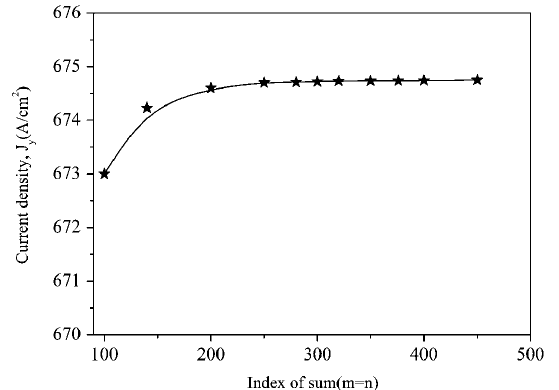
FIG. 6. Evaluation of the eddy current from the analytical expression of Eq. (19) for different indices of the sum ( m ¼ n ). The solid line is just a guide to the eye.